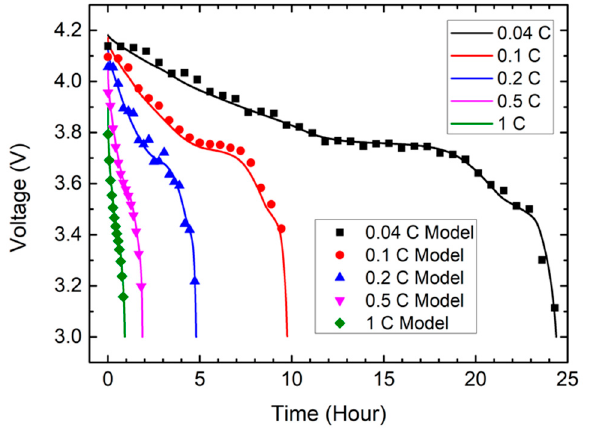
Figure 8. Curve of L brand 18650, Epoch = 100, look_back = 10.